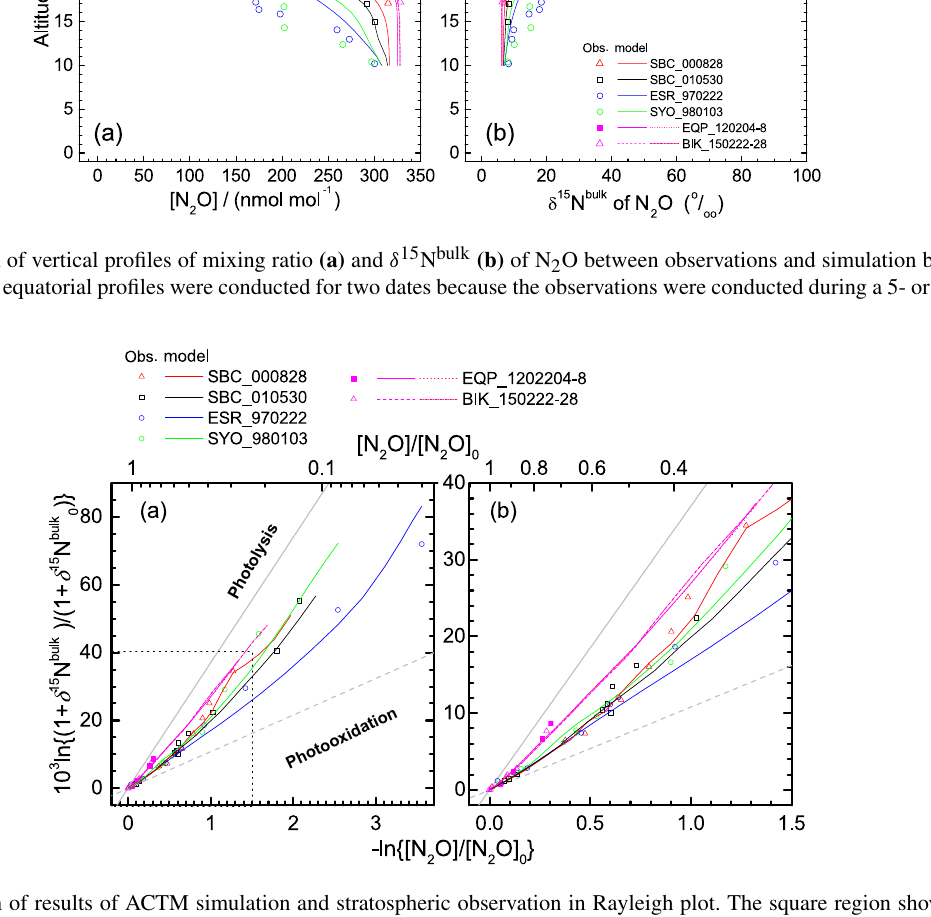
Figure 9. Comparison of results of ACTM simulation and stratospheric observation in Rayleigh plot. The square region shown by broken lines in panel (a) is enlarged in panel (b)